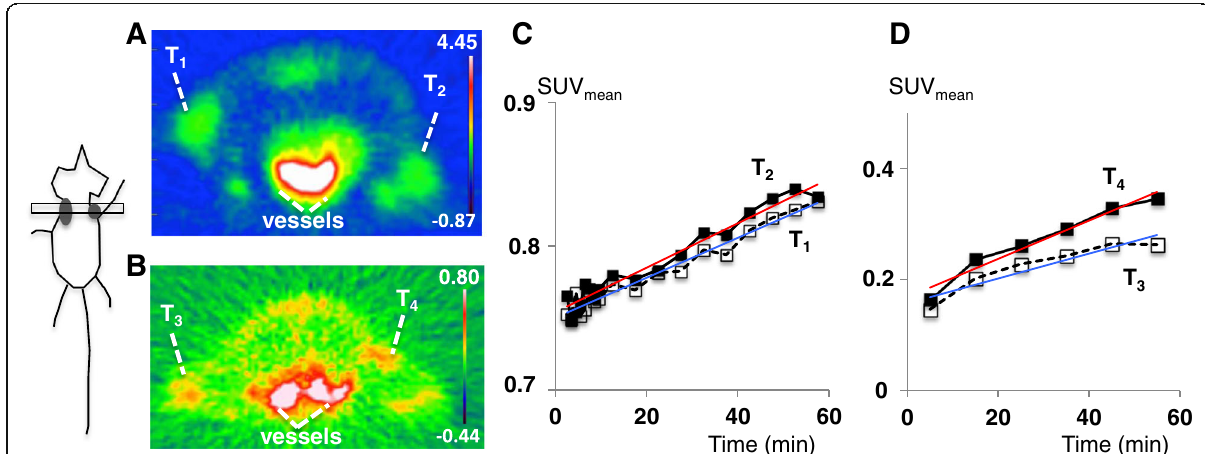
Fig. 4 Differing uptake of albumin-bound [ 68 Ga]ABY-028 in two xenograft tumor models in NIH-Foxn1mu rats. Both images are summed over 60 min from tracer injection. The scheme to the left shows the approximate location of the xenografts. The dynamic ranges of the SUV mean scales for each image are shown in the color bars to the right. Transaxial PET images are a the two FaDu xenografts T 1 and T 2 and b the two A431 xenografts T 3 and T 4 . TACs are for c FaDu tumors T 1 and T 2 and for d A431 tumors T 3 and T 4 . The y -axes are different in the two graphs to facilitate visual comparisons between the uptakes in each of the two tumors. Fitted lines are drawn in red and